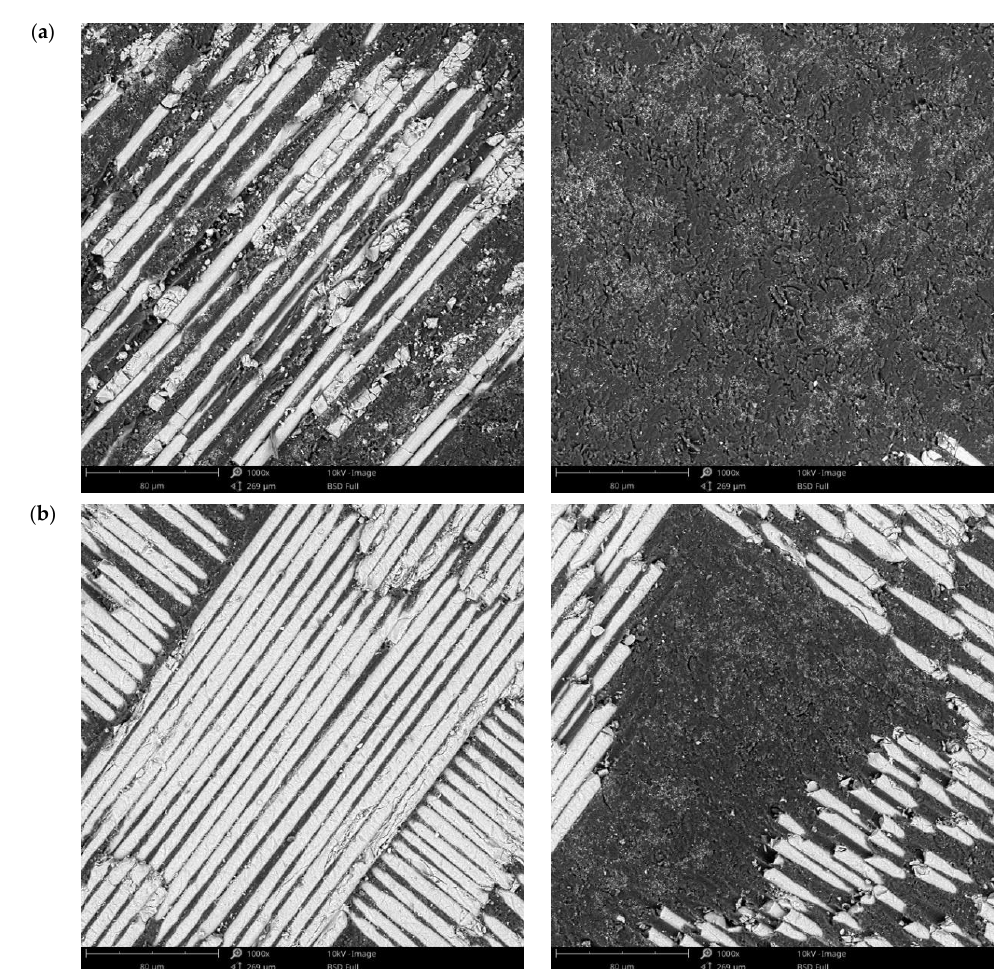
Figure 11. SEM images of the C2 sample surface after immersion tests at ( a ) 3 days and ( b ) 21 days in artificial saliva with varying pH (1000×).